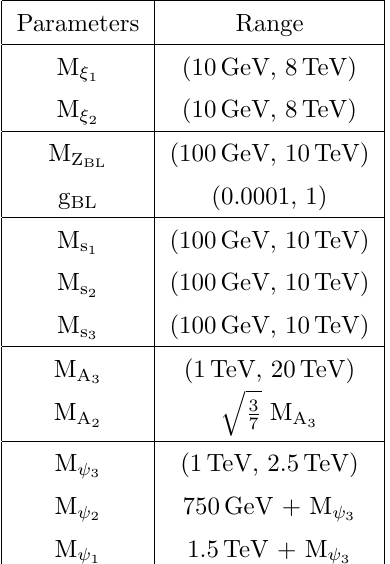
M Z plane allowed from total DM BL (cid:0)